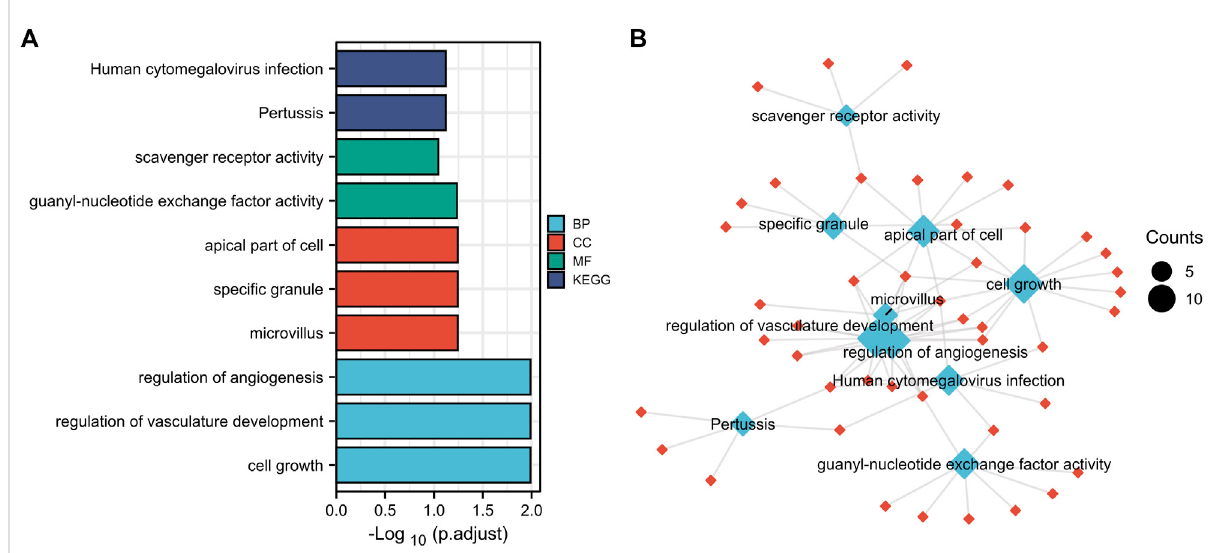
FIGURE 3 Function annotation of 144 common DEGs. (A) , GO terms (BP, MF, CC) and KEGG analysis of overlapped common DEGs ( p < 0.01). GO, Gene Ontology. BP, biological process, MF, molecular function, CC, cellular component. KEGG, Kyoto Encyclopedia of Genes and Genomes. (B) , network of GO and